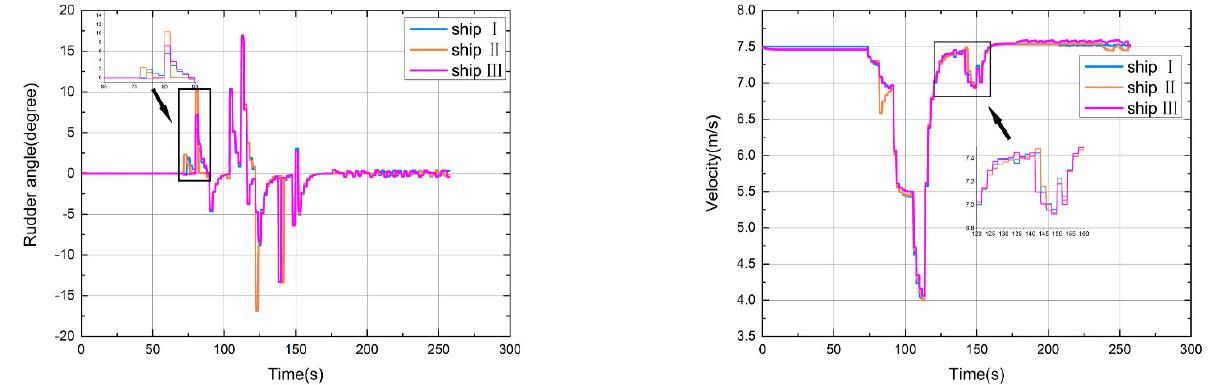
Figure 15. The rudder angle and velocity of three ships.